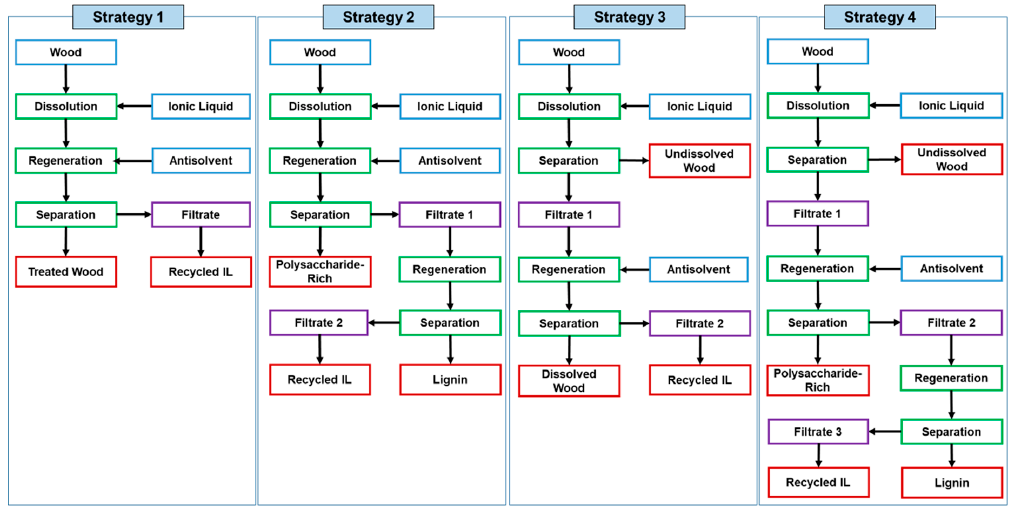
Figure 3. The different fractionation strategies followed in the literature upon partial or complete dissolution of wood or lignocelluloses.